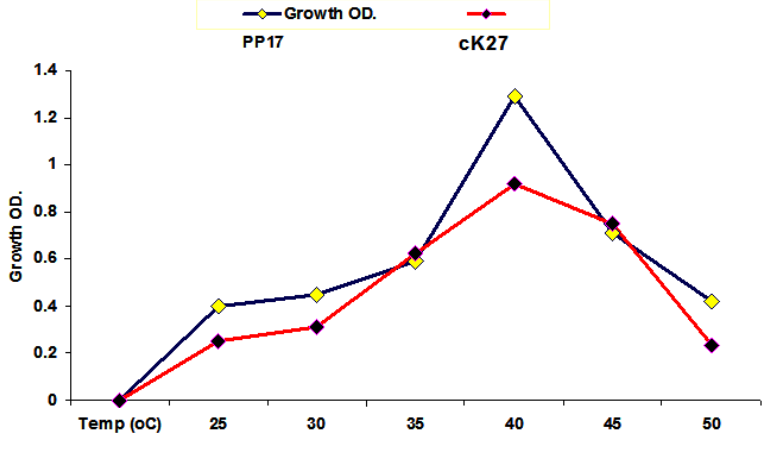
Fig. 4. Growth of LAB strains CK21 and PP17 at wide temperature range